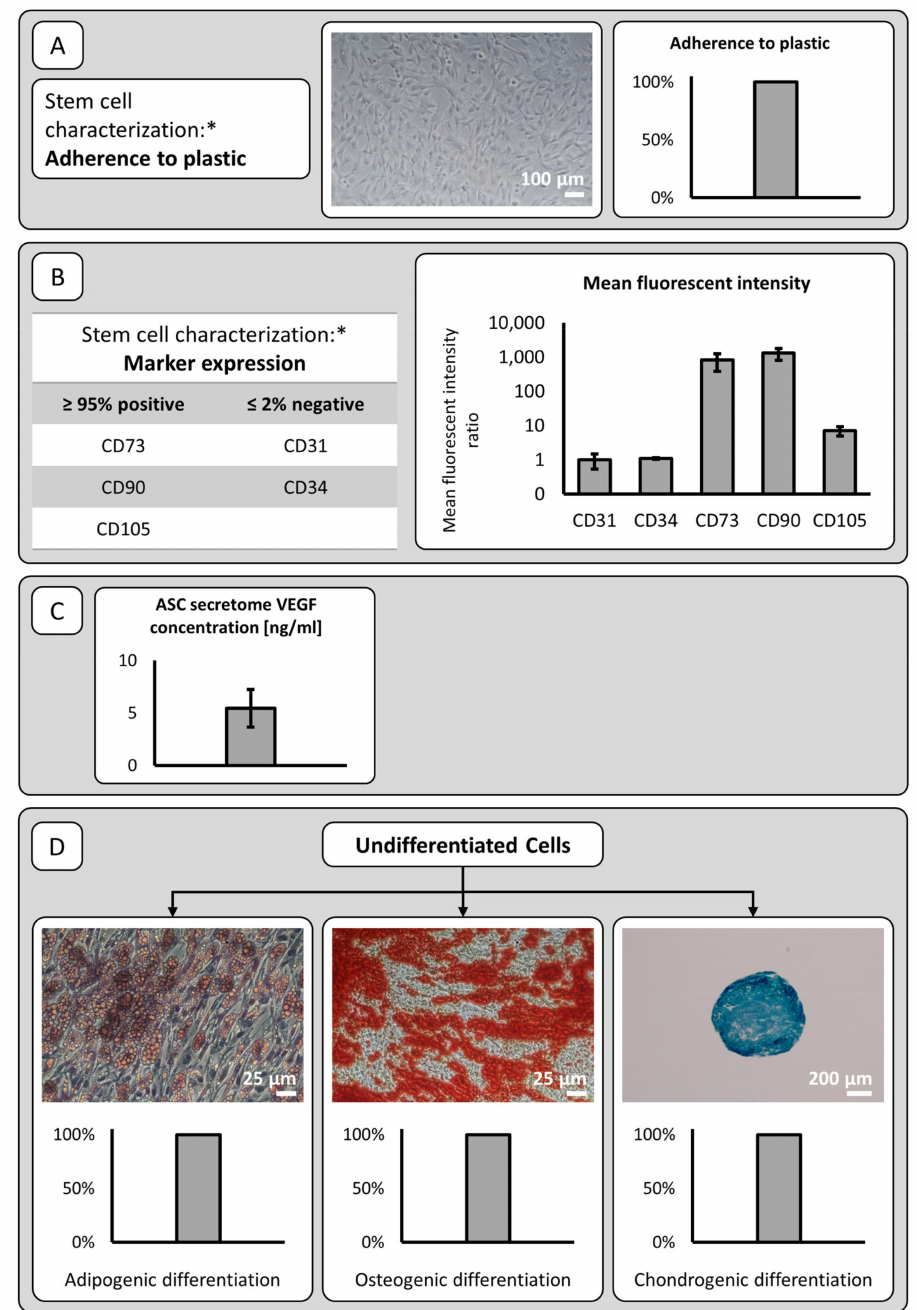
Figure 1. Mesenchymal stromal cell characterization was performed as described previously (*) [13]: ( A ) Mean Plastic adherence was found in all patient cell lines. A representative photograph is shown. ( B ) Cell lines were tested for positivity or negativity of the indicated markers using flow cytometry of passage 2 cells. All patient cell lines were positive for CD73, CD90, and CD105 and negative for markers CD31 and CD34 (mean fluorescent intensity (MFI) ± SD), as expected for mesenchymal stromal cells. ( C ) ELISA results for VEGF in ASC culture supernatants collected in passage 1 are shown. Results for cell culture supernatants are normalized to ng/106 cells (mean ± SD). ( D ) Lipid vesicle accumulation visualized by Oil Red O staining in adipogenic differentiated ASCs after two weeks of incubation with adipogenic differentiation medium (magnification 200 × ). Alizarin S staining of extracellular calcium deposits in osteogenic differentiated ASCs after two weeks of incubation with osteogenic differentiation medium (magnification 200 × ). Alcian blue staining of cartilage extracellular matrix in ASCs cultured as three-dimensional spheroids after four weeks of incubation with chondrogenic differentiation medium (magnification 40 × ). Shown are representative images of n = 5 independent